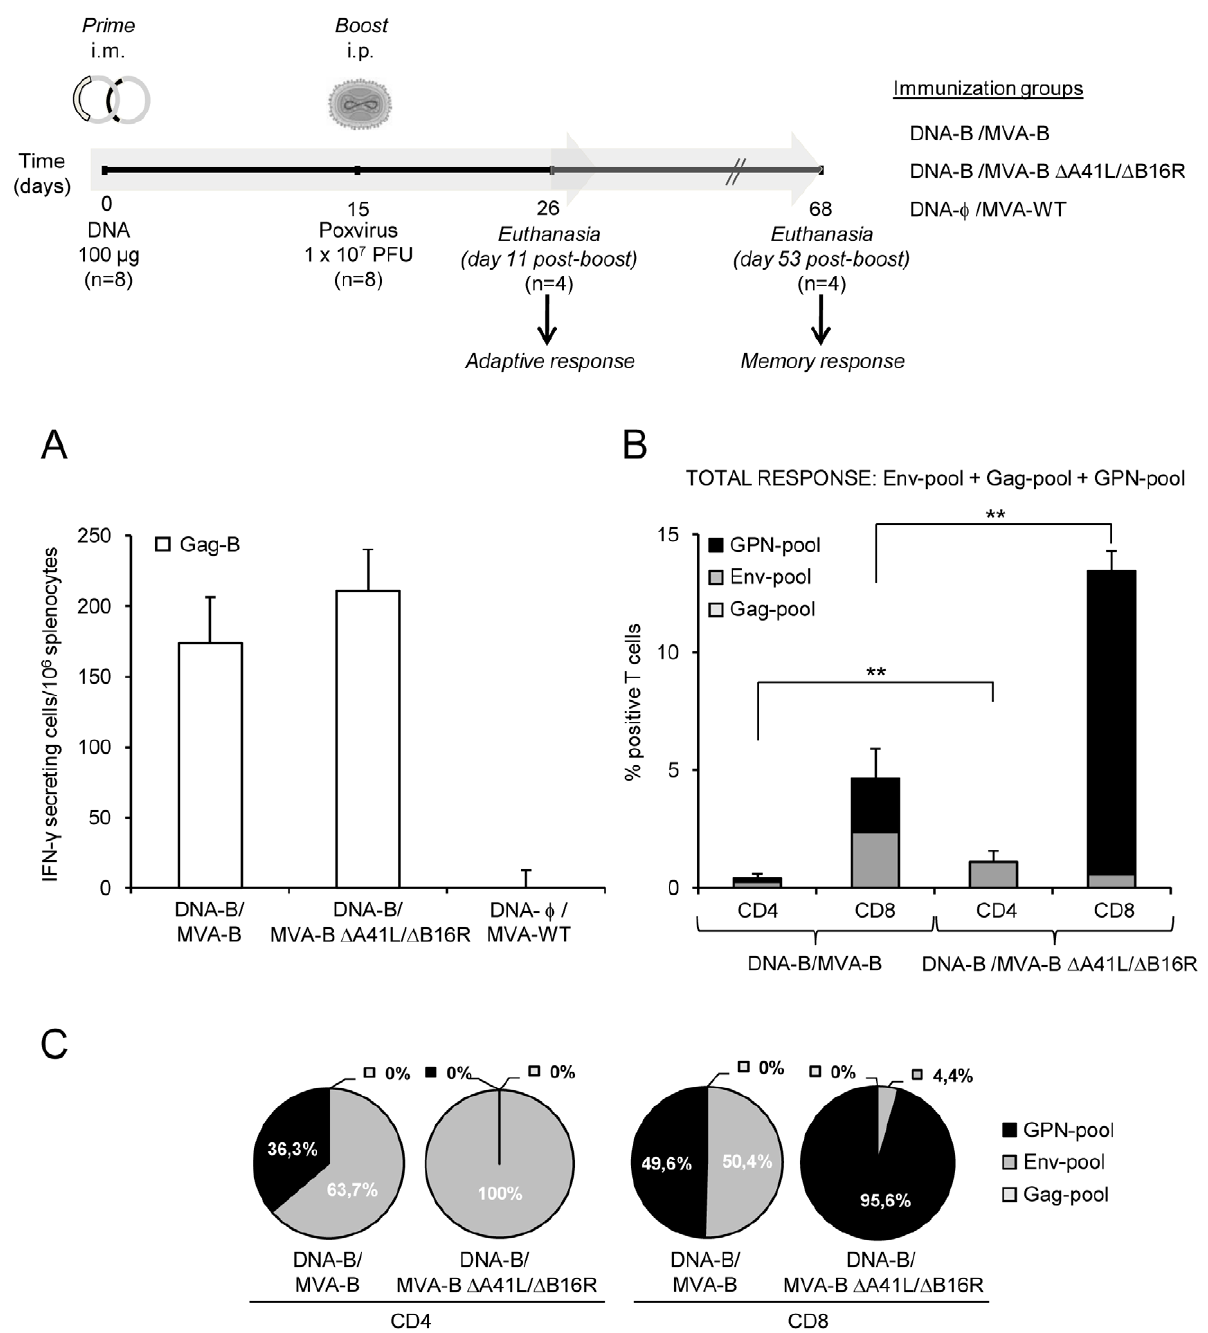
Figure 2. HIV-1-specific adaptive immune responses induced by MVA-B and MVA-B D A41L/ D B16R. (Upper) Scheme of the DNA prime/ MVA-boost immunization protocol used in this study. BALB/c mice were primed i.m with 100 m g of DNA-B (50 m g of pCMV- BX08 gp120 + 50 m g of pCDNA- IIIB GPN), or control DNA and two weeks later infected i.p with 1 6 10 7 PFU of MVA-B, MVA-B D A41L/ D B16R or MVA-WT. (A) Vaccine-elicited T- cell responses of splenocytes 11 days after the last immunization with MVA-B, MVA-B D A41L/ D B16R or MVA-WT, in a fresh IFN- c ELISPOT assay following stimulation with HIV-1 peptide Gag-B. Bars represent the total number of Gag-B-specific IFN- c secreting cells per 10 6 splenocytes in each group. Standard deviations from triplicate cultures are shown. *, represent statistically significant differences between groups, p , 0.05. A representative experiment out of two is shown. (B) Total HIV-1-specific CD4 + and CD8 + T-cell immune responses induced in mice 11 days after the last immunization with DNA-B/MVA-B or DNA-B/MVA-B D A41L/ D B16R, measured by flow cytometry using ICS assay, following stimulation with different HIV-1 peptide pools that covered the entire HIV-1 sequence present in the poxvirus vector (Env-pool, Gag-pool and GPN-pool). The percentage of HIV-1-specific CD4 + and CD8 + T-cell responses directed against Env-pool, Gag-pool and GPN-pool is indicated by different color codes, and the frequencies were calculated as the addition of single, double and triple positive T cells for the secretion of IFN- c , TNF- a and IL-2; thus, each responding cell was counted once. The background of the unstimulated controls was subtracted in all cases, and only significant values over the background are represented. Standard deviations are shown. **, represent statistically significant differences between groups, p , 0.005. (C) The pie charts summarize the data of panel B, with each set representing the fraction of CD4 + or CD8 + T cells specific for Env-pool, Gag-pool and GPN-pool.